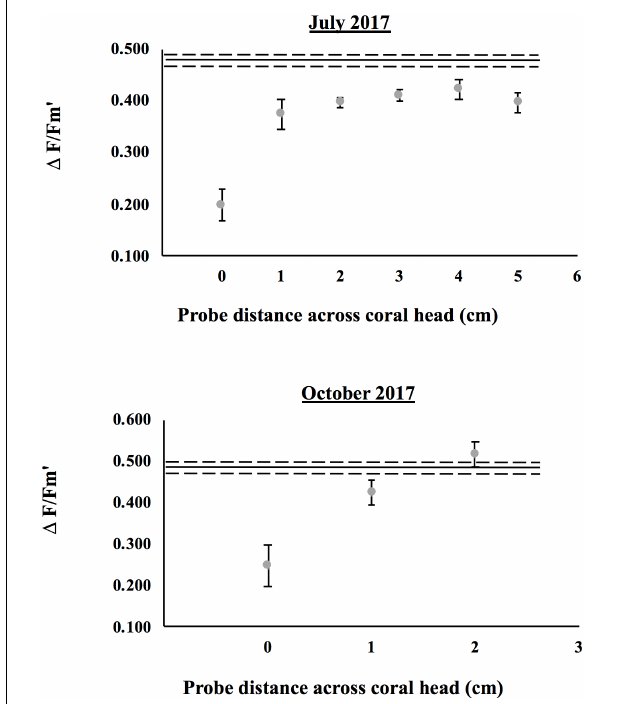
FIGURE 6 | Comparisons of effective quantum yield ( (cid:49) F/Fm’) across colonies of Montastraea cavernosa in July and October 2017. The solid line represents the mean yield of healthy colonies across the probe transect (dashed lines represent the standard error). For healthy corals, yield transects were initiated at a haphazard location on the upper surface of the colony. Gray symbols represent individual yields (means ± SE) for diseased colonies along the linear transect. For diseased corals, yield measurements started at the bleached lesion front (0 cm) and progressed along a linear transect toward tissue healthy in appearance (2–6 cm